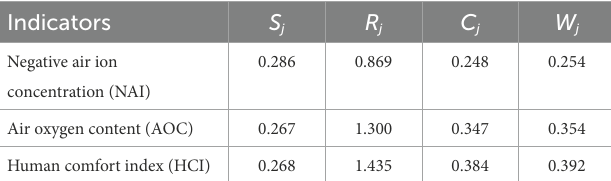
TABLE 4 The weight calculation result by CRITIC